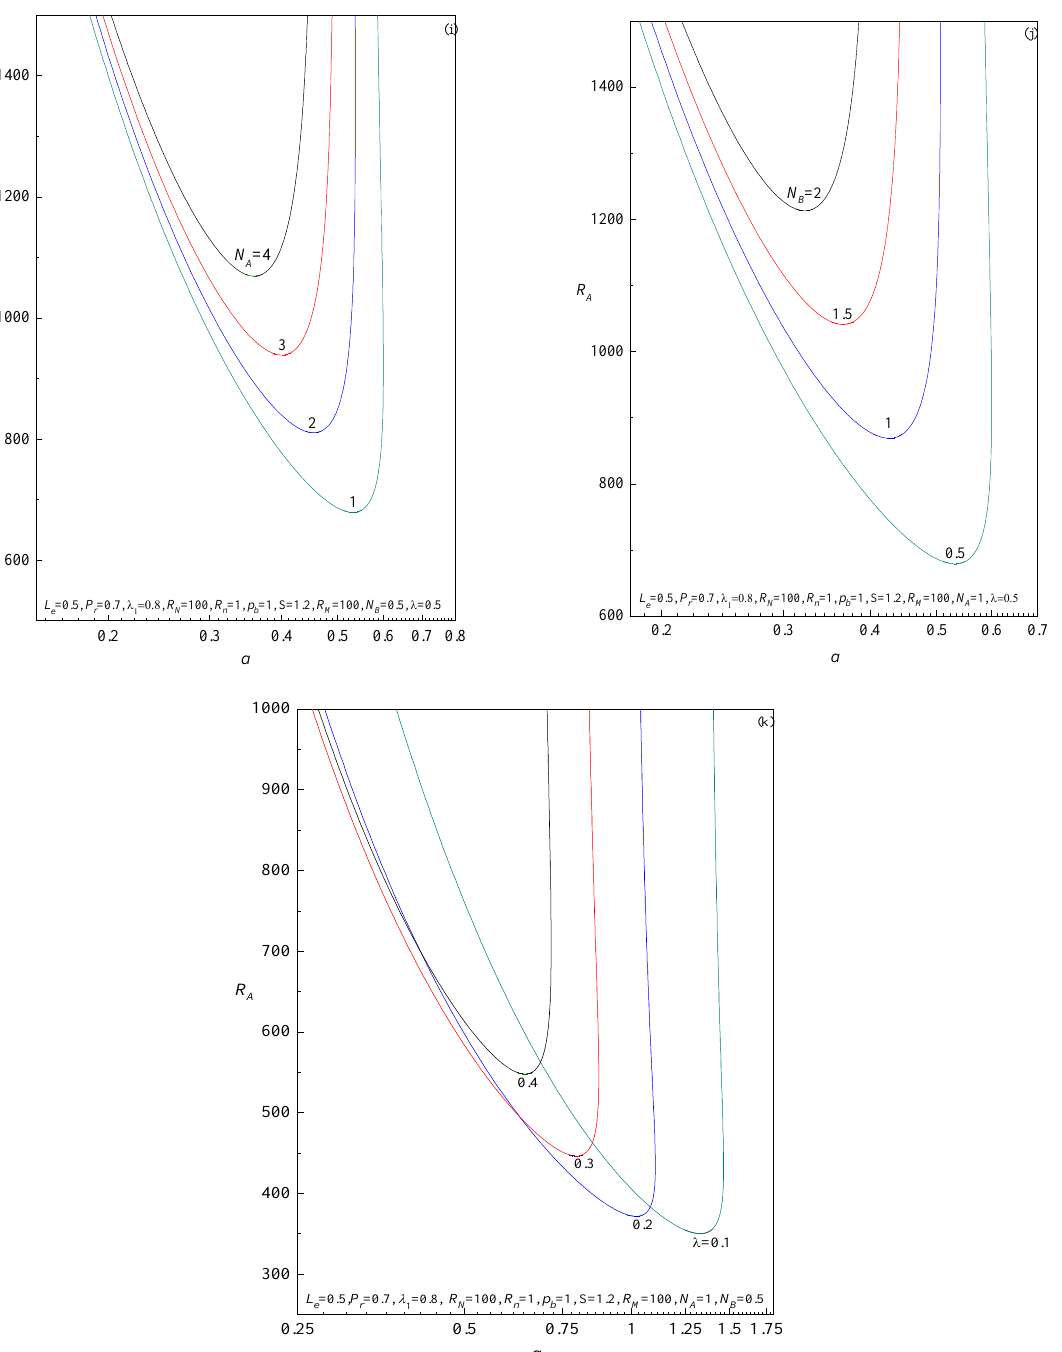
Figure 3. Plots of neutral stability curves in the (𝑎,𝑅 𝐴 ) -plane for different values of ( a ) 𝐿 𝑒 , ( b ) 𝑃 𝑟 , ( c ) 𝜆 1 , ( d ) 𝑅 𝑁 , ( e ) 𝑅 𝑛 ,( f ) 𝑝 𝑏 , ( g ) 𝑆 , ( h ) 𝑅 𝑀 , ( i ) 𝑁 𝐴 , ( j ) 𝑁 𝐵 and ( k ) 𝜆 , obtained from the eigenvalue system (45).